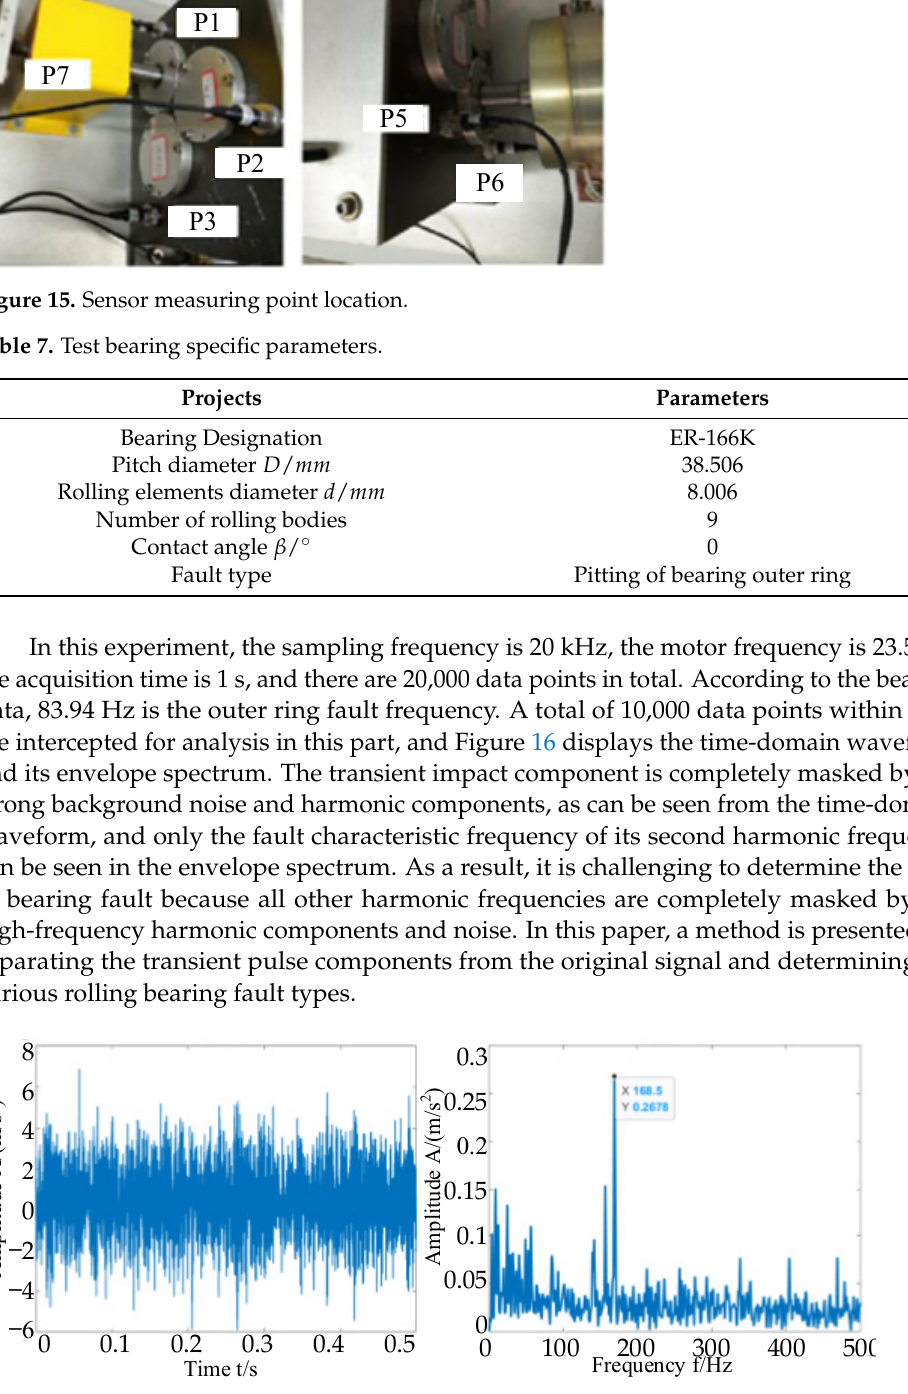
Figure 16. Time-domain waveform and envelope spectrum of signal of the test bearing.